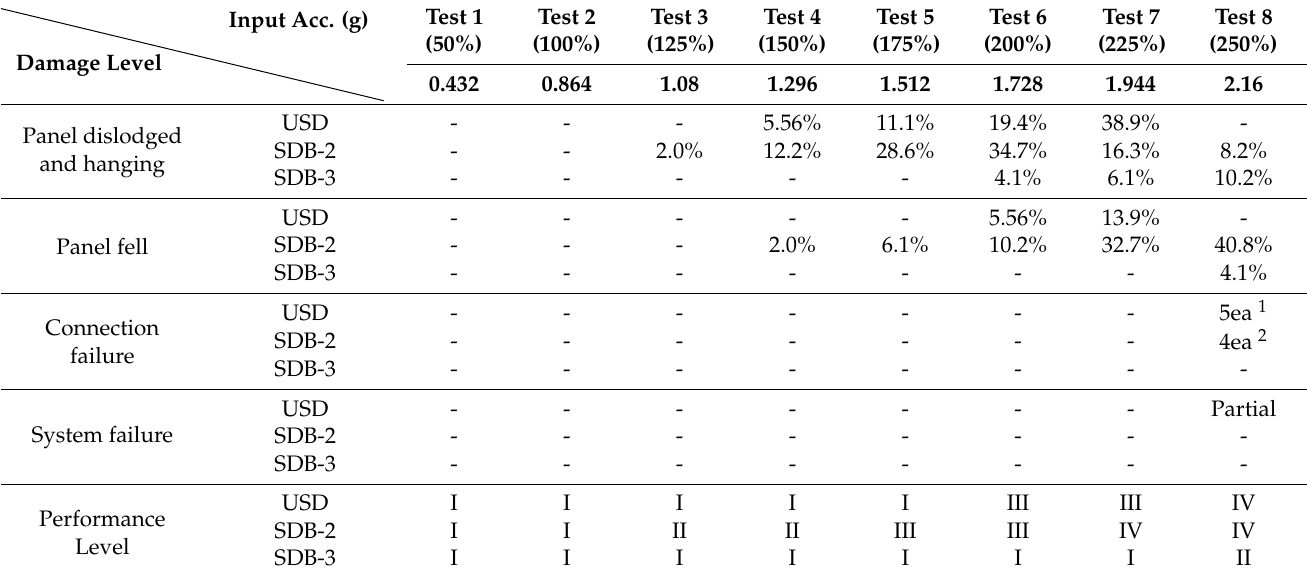
Table 7. Percentage of the damaged panels and the performance level of the ceiling